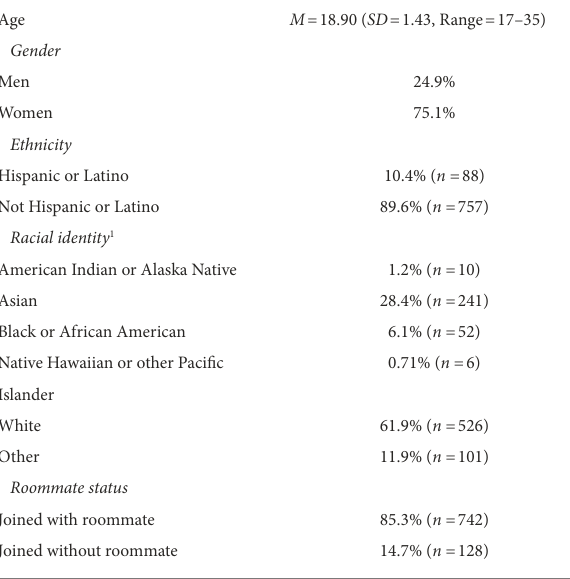
TABLE 2 Participant